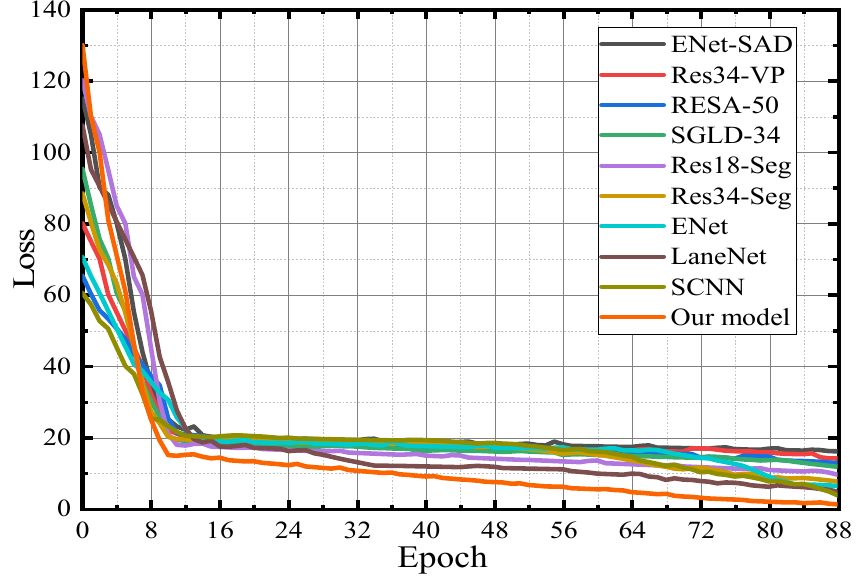
Figure 12. Model verification—loss function graph.